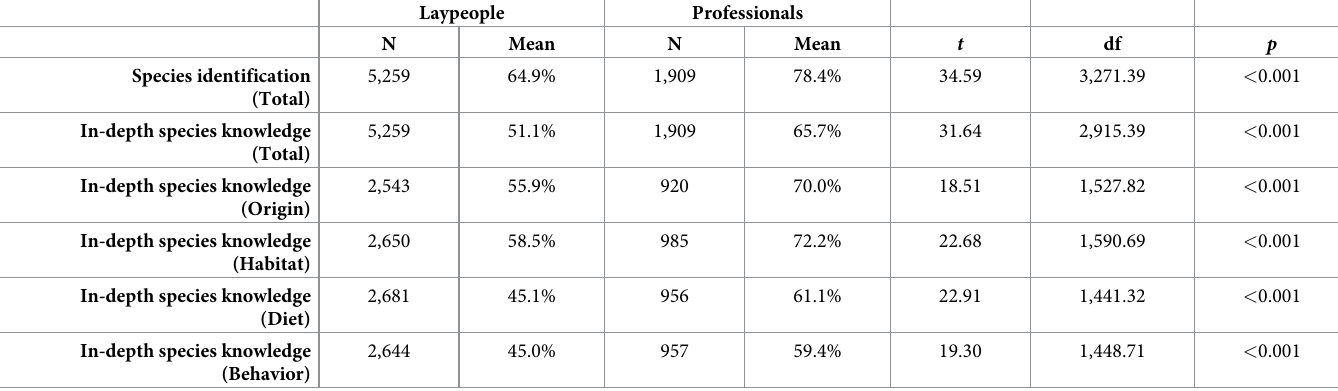
Table 2. Welch’ independent samples t -tests comparing species literacy levels in laypeople and biodiversity professionals. Two components of species literacy were tested: species identification and in-depth knowledge about species (subdivided into four themes).